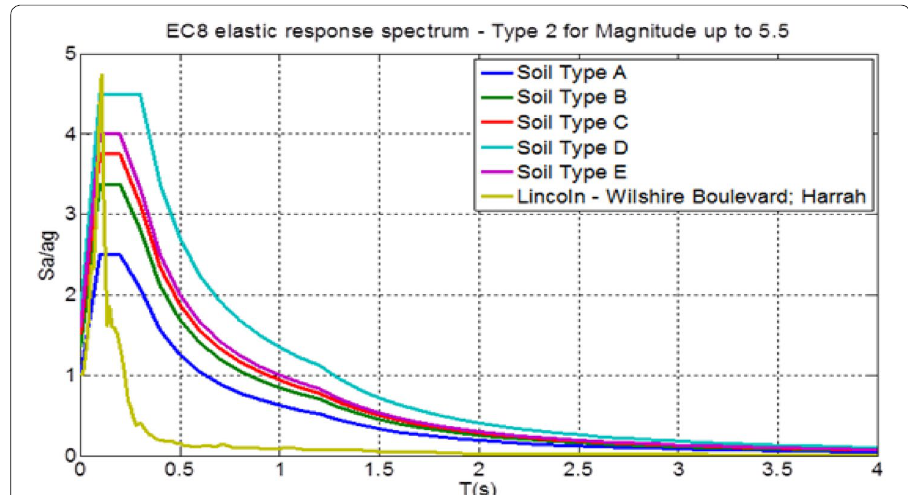
Fig. 7 Elastic response spectra of the induced seismic ground motions obtained from the PEER database and their comparison with the Eurocode 8 type 2 elastic response spectrum for magnitudes up to 5.5. In the legend, the soil types A–E (rock [A] to softer soils [E]) refer to the different Eurocode 8 type 2 elastic response spectra produced for different soil conditions according to Eurocode 8. The remaining term in the legend refers to the name of the seismic station (PEER database) which recorded the induced seismic event’s (Lincoln, Table 1) ground motion used to produce the elastic response